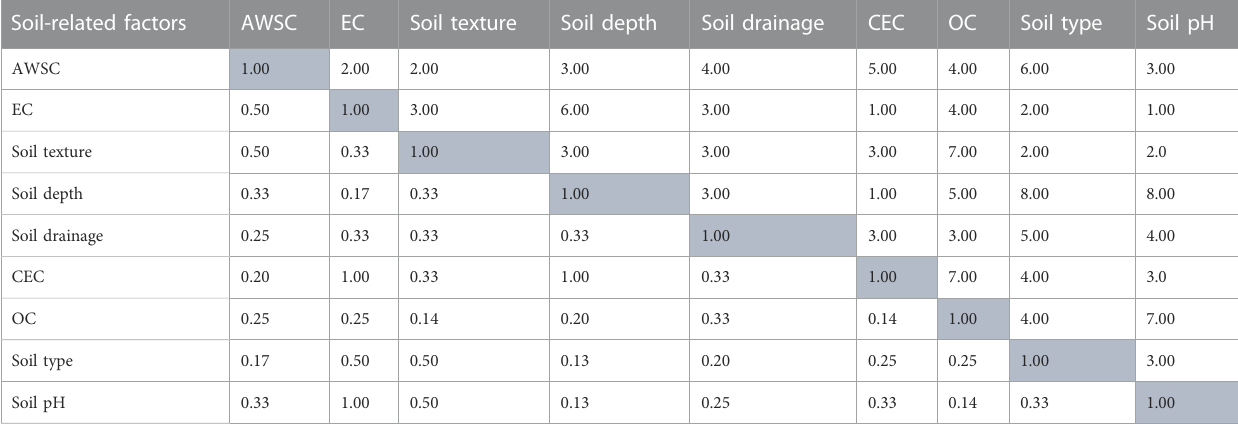
TABLE 8 Pair-wise comparison matrix/comparative importance of the soil-related factors considered to determine the surface irrigation potentials of the Chacha Watershed. Soil-related factors